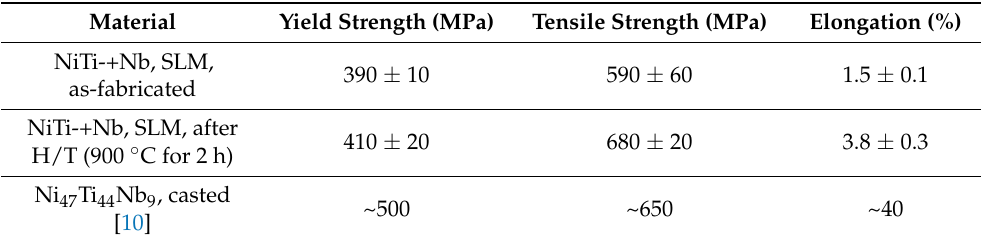
Table 2. The results of tensile tests at room temperature for NiTiNb samples in the as-fabricated and heat-treated state.